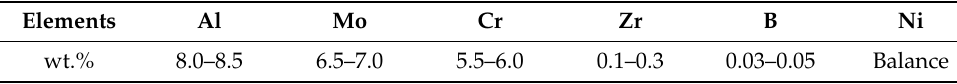
Table 1. Chemical compositions of Ni 3 Al-based alloy (wt.%).